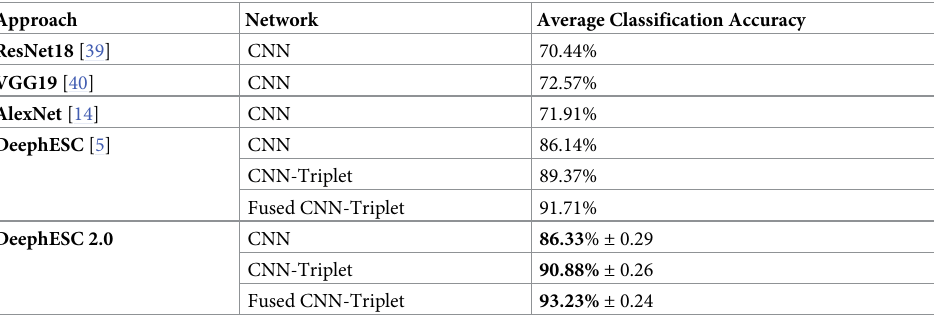
Table 8. Comparison of the average classification accuracy of the networks used in DeephESC and DeephESC